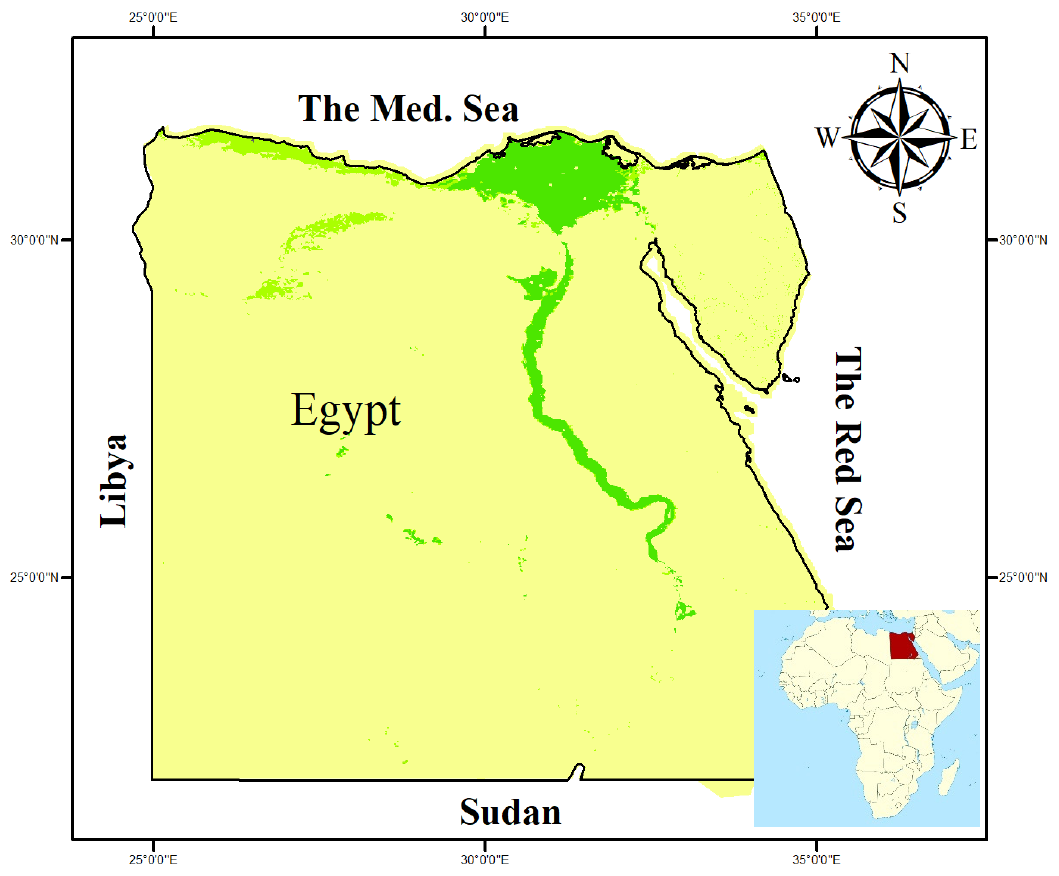
Figure 1. Egypt location map.